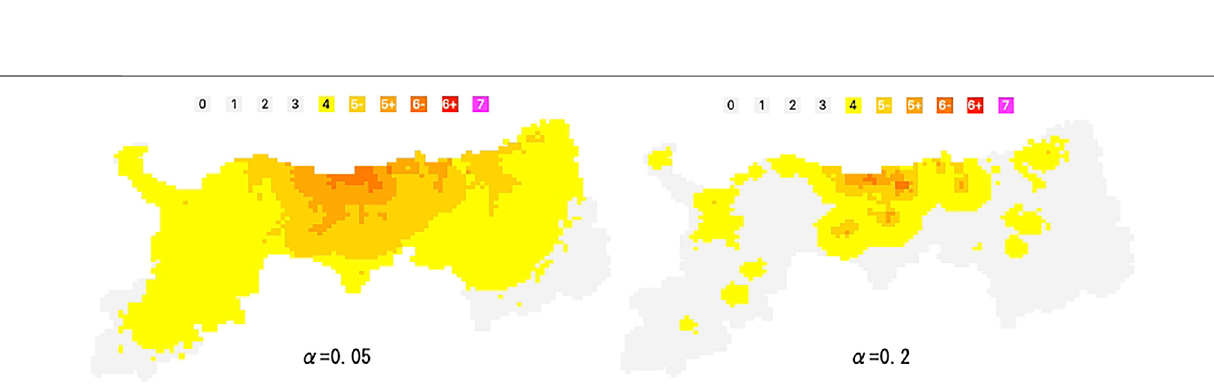
Frontiers in Earth Science |